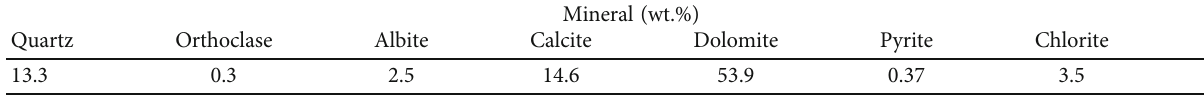
Table 1: Mineralogical composition of the studied